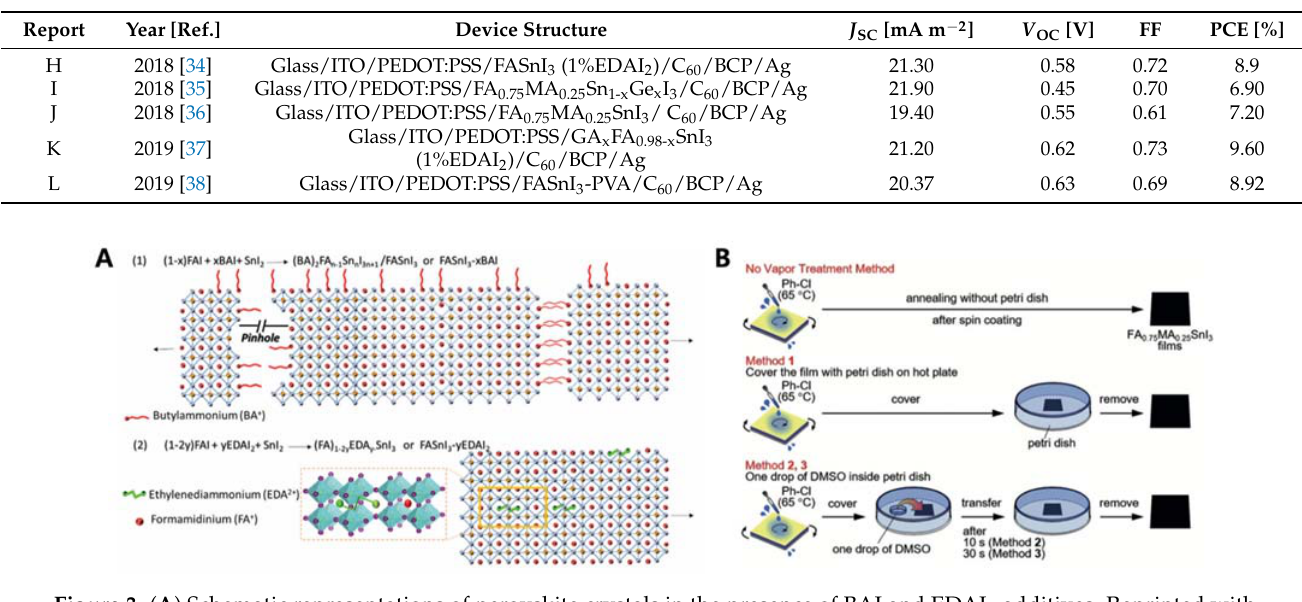
Table 5. Record table containing the reported Sn-PSCs and the corresponding photovoltaic param-